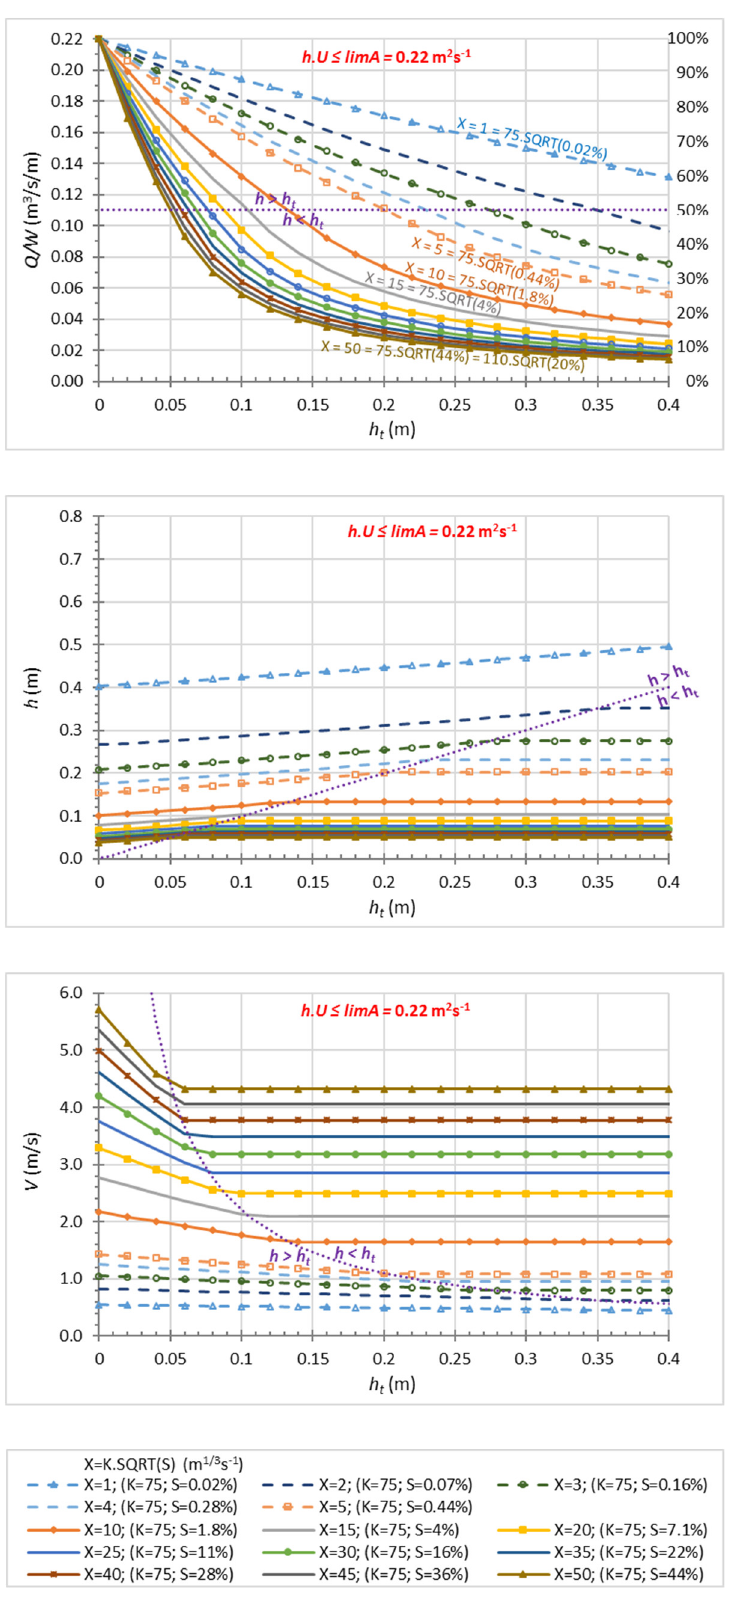
Figure 2. Variations of h , V and Q / W fulfilling the thresholds of criterion h . V = 0.22 m 2 s − 1 , as a function of h t and K .